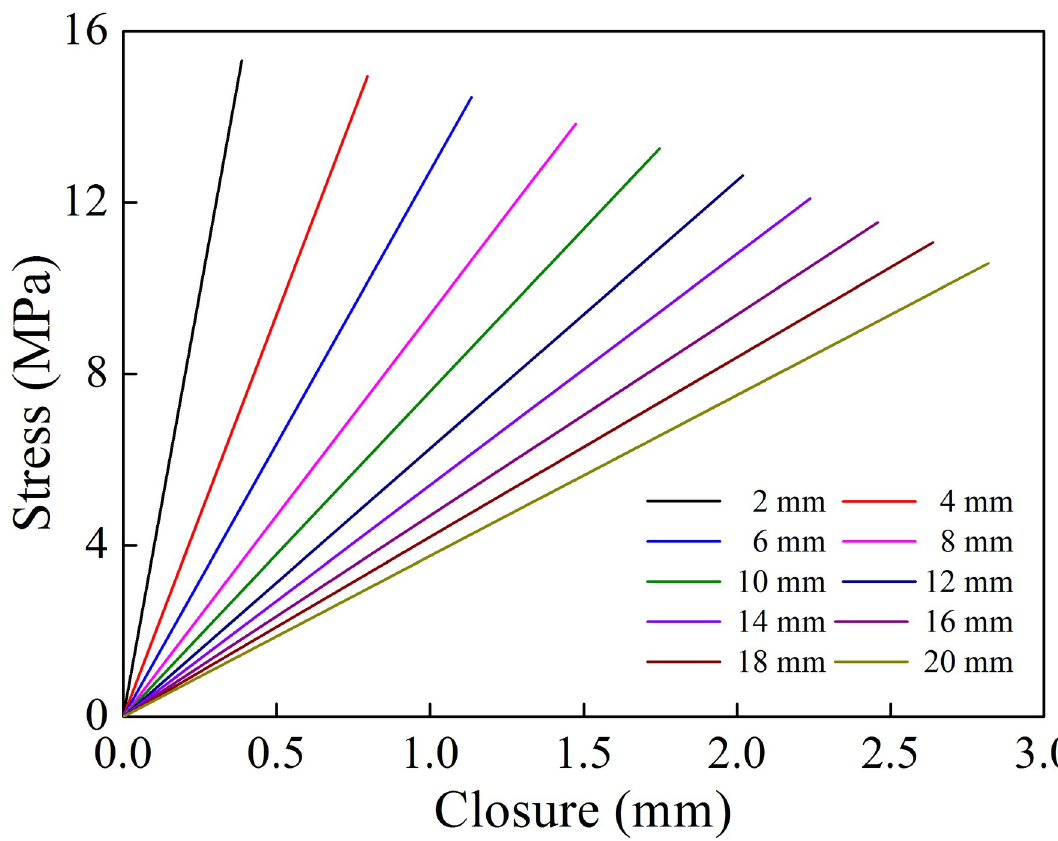
Fig 4. Relationship between normal stress and closure (a single filled